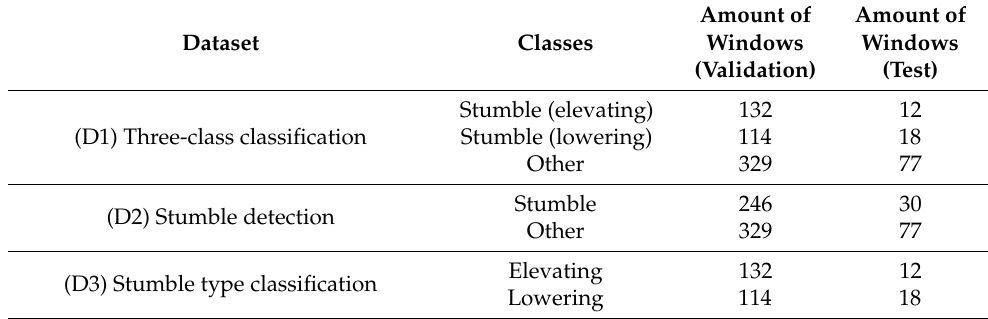
Table 2. Labelled datasets.